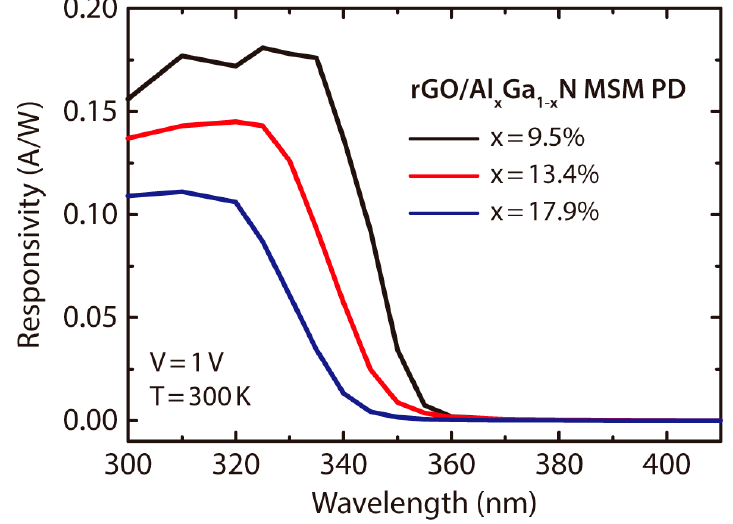
Figure 5. Spectral photoresponses of the rGO/AlGaN MSM photodiodes with various Al mole